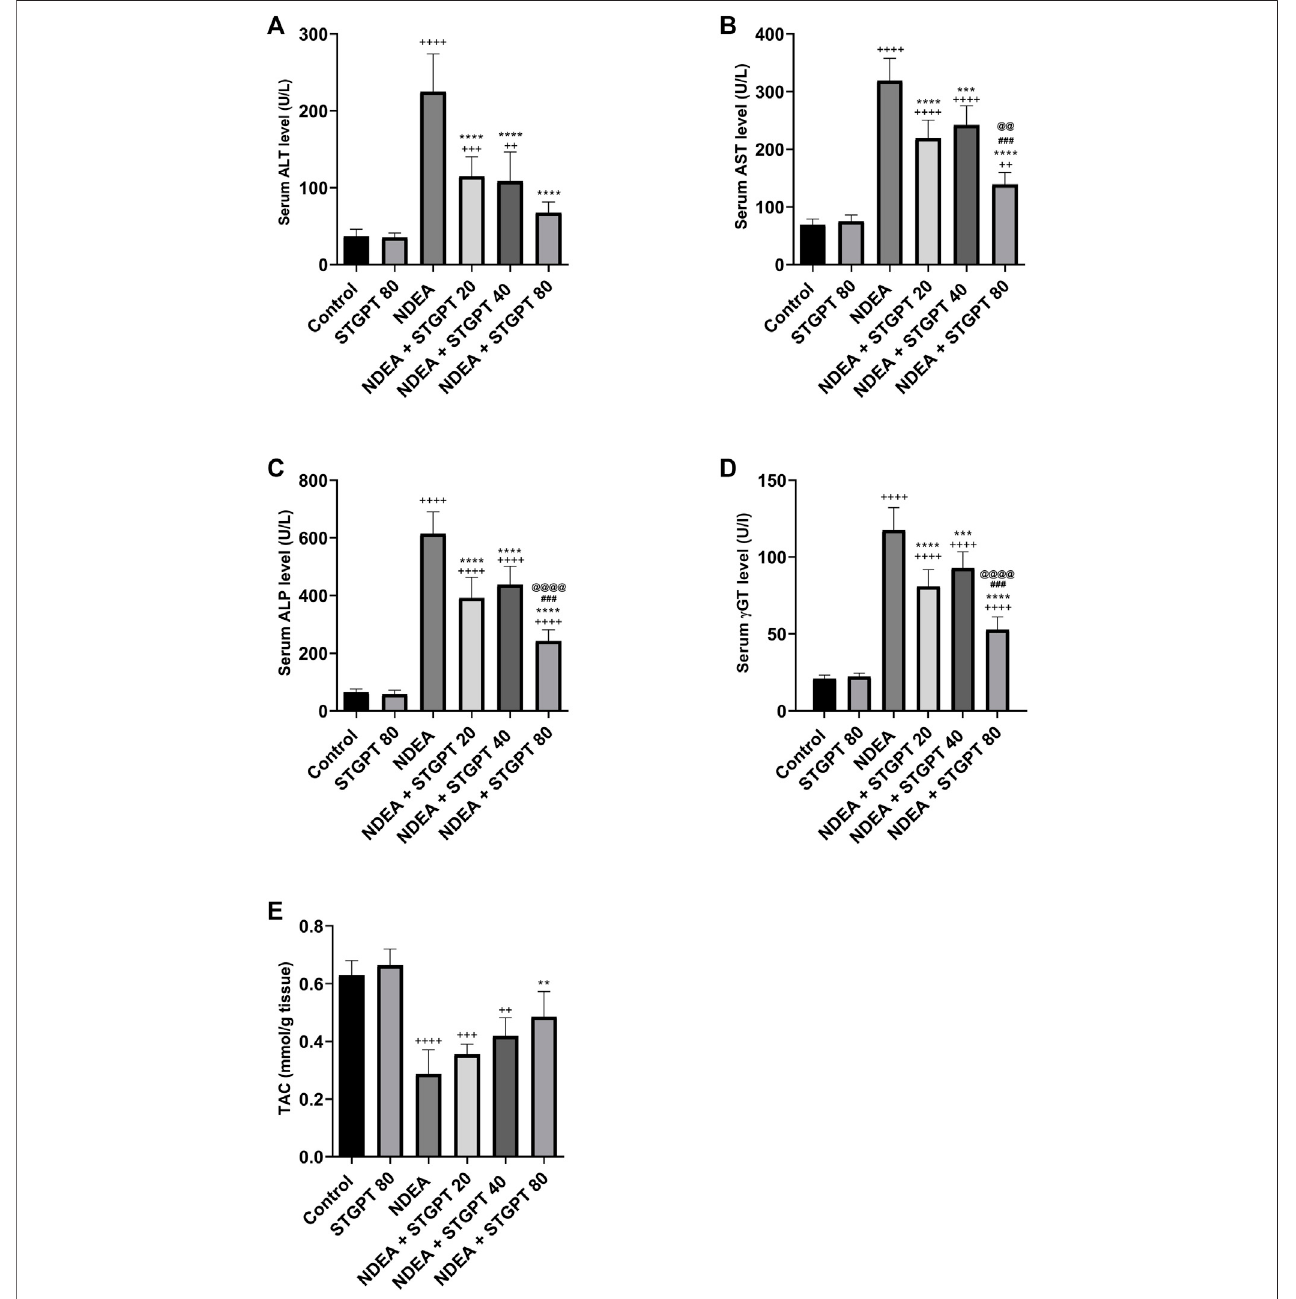
FIGURE 3 | Effect of STGPT (20, 40 and 80 mg/kg) on ALT (A) ; AST (B) ; ALP (C) ; γ -GT (D) ; and TAC (E) in mice with NDEA-induced HCC. Data are presented as the mean ± SD ( n (cid:1) 6). + p < 0.05 vs. Control group, ++ p < 0.01 vs. Controlgroup, +++ p < 0.001 vs. Control group, ++++ p < 0.0001 vs. Controlgroup, ** p < 0.01 vs NDEA group, *** p < 0.001 vs. NDEAgroup, **** p < 0.0001 vs. NDEAgroup, ### p < 0.001 vs STGPT 20group, @@ p < 0.01 vsSTGPT 40group, @@@@ p < 0.0001vs STGPT 40 group.Control,normalcontrolgroupreceivedthevehicle;STGPT80,normalgroupreceivedsitagliptin(80 mg/kg);NDEA,NDEA-inducedHCCgroupreceivedthe vehicle; NDEA + STGPT 20, NDEA-induced HCC group treated with sitagliptin (20 mg/kg); NDEA + STGPT 40, NDEA-induced HCC group treated with sitagliptin (40 mg/kg); NDEA + STGPT 80, NDEA-induced HCC group treated with sitagliptin (80 mg/kg).